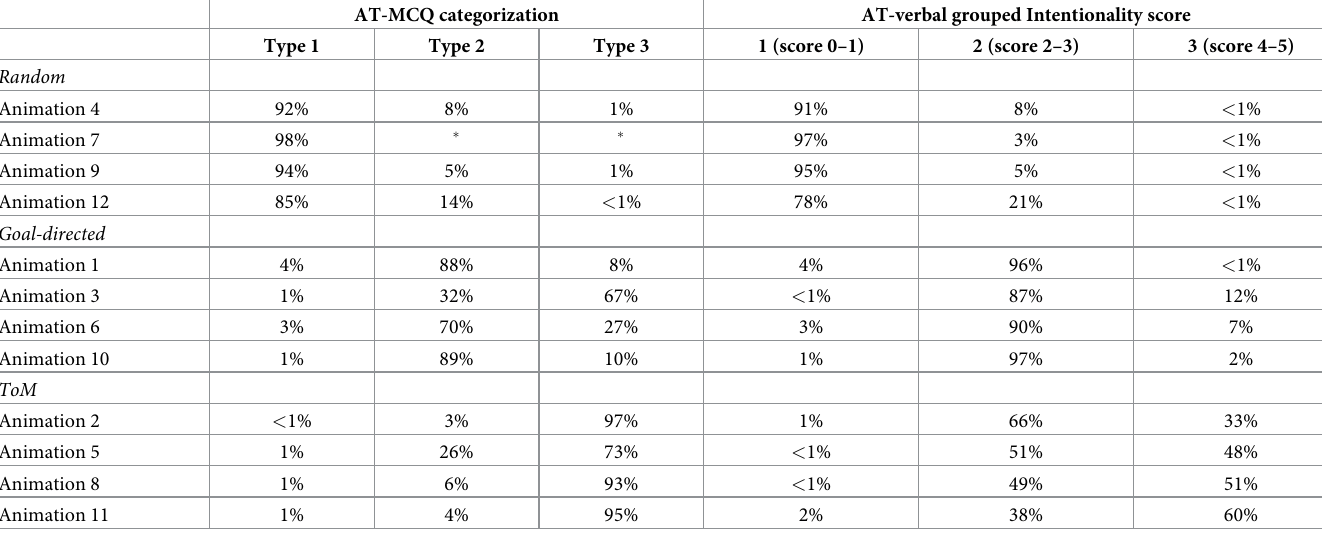
Table 2. Distribution of AT-MCQ categorizations and AT-verbal intentionality scores given in